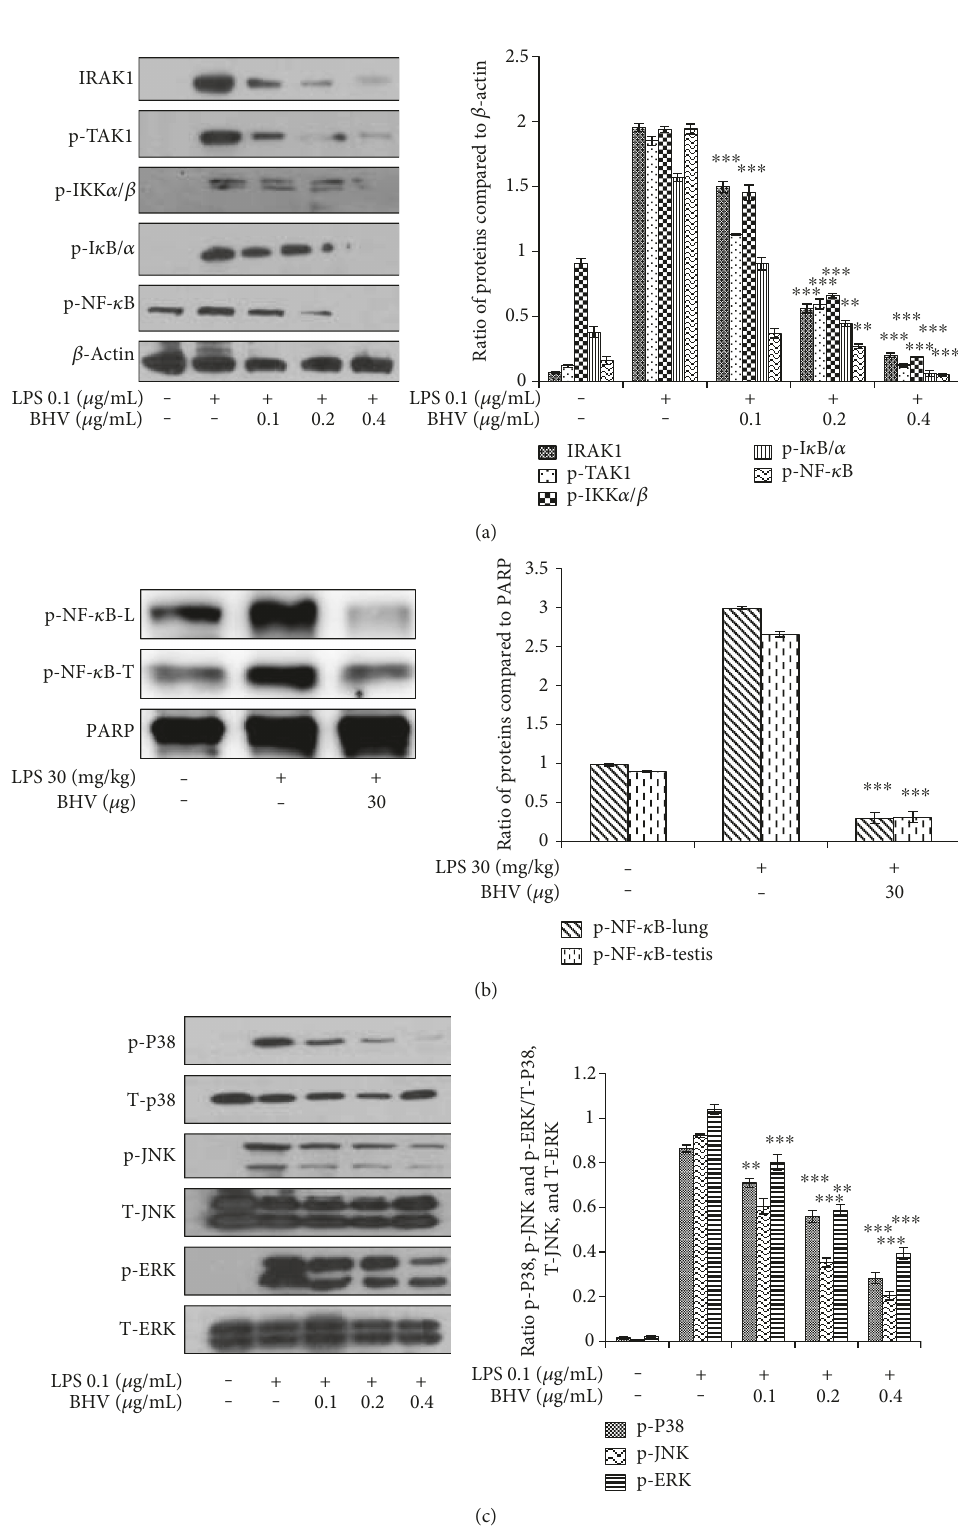
Figure 5: NF- κ B and MAPK pathways are followed by B. hebetor venom. RAW 264.7 cells were pretreated with BHV at the indicated concentrations (0.1 μ g/mL – 0.4 μ g/mL) and then stimulated with or without LPS (0.1 μ g/mL) for 18 hr. Nuclear and cytosolic proteins from cells and tissues were extracted using NE-PER extraction kit. Proteins were run on SDS-PAGE and treated with primary antibodies overnight followed by incubation with secondary antibodies for 2hr. Expression of proteins in cells (a). Expression of proteins in lung and testis tissue (b). MAPK pathway proteins expression (c). The membranes were analyzed by ECL chemiluminescence system. Data are mean ± SD ( n = 3 ); ∗∗ p < 0 005 and ∗∗∗ p < 0 001 compared with LPS only. β -actin was taken as internal